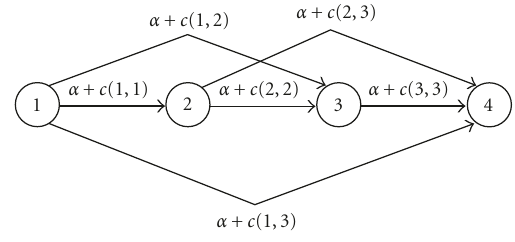
Figure 5: Example of a directed acyclic graph with three segments.